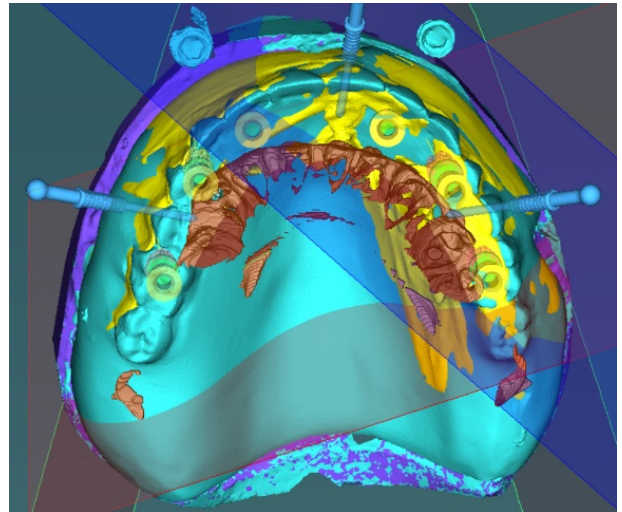
Figure 1. Registration of the optical scans and cone beam computed tomography (CBCT) reconstruction and the plan of the surgical template.